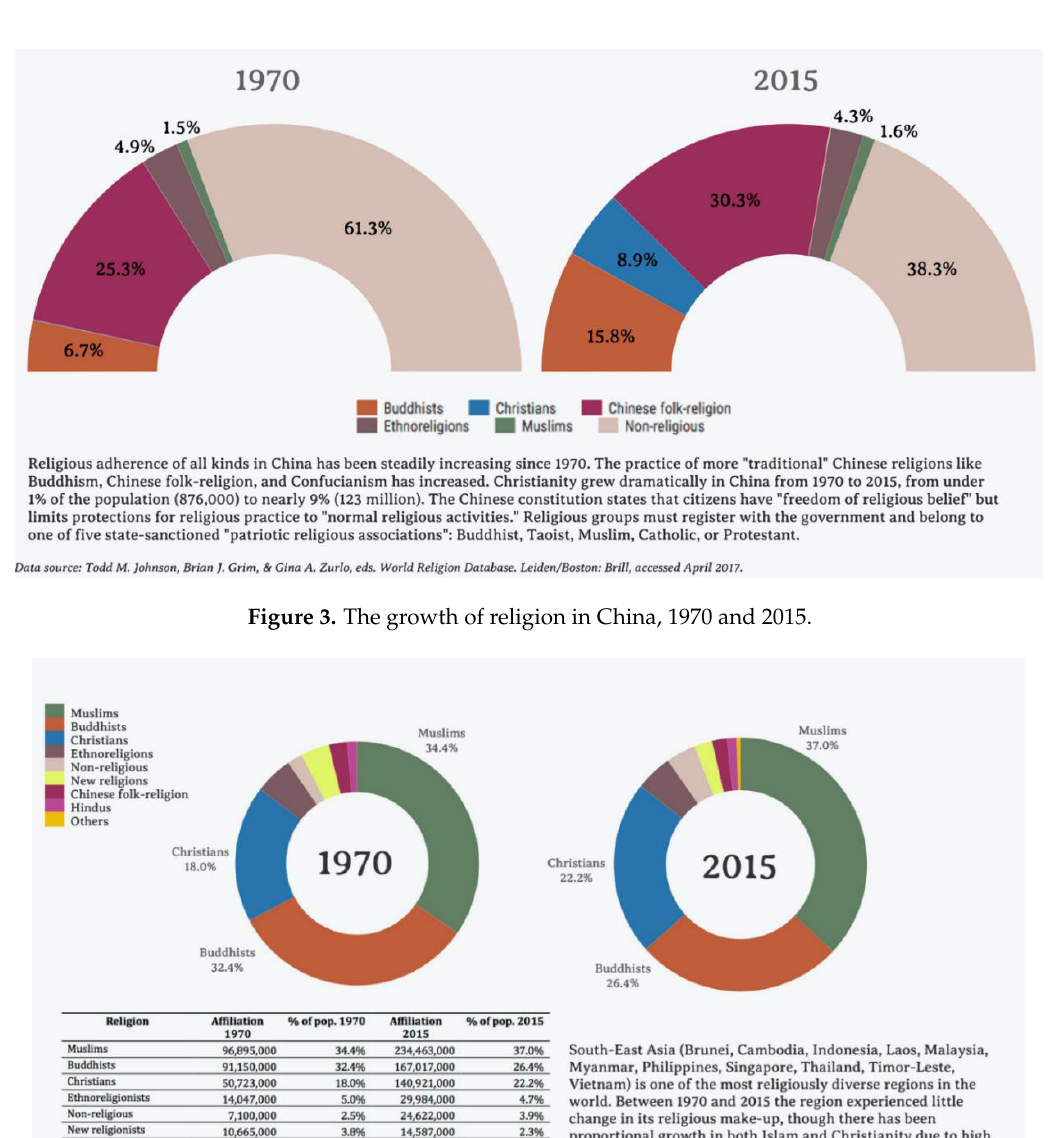
Figure 4. Religious diversity in Southeast Asia, 1970 and 2015.